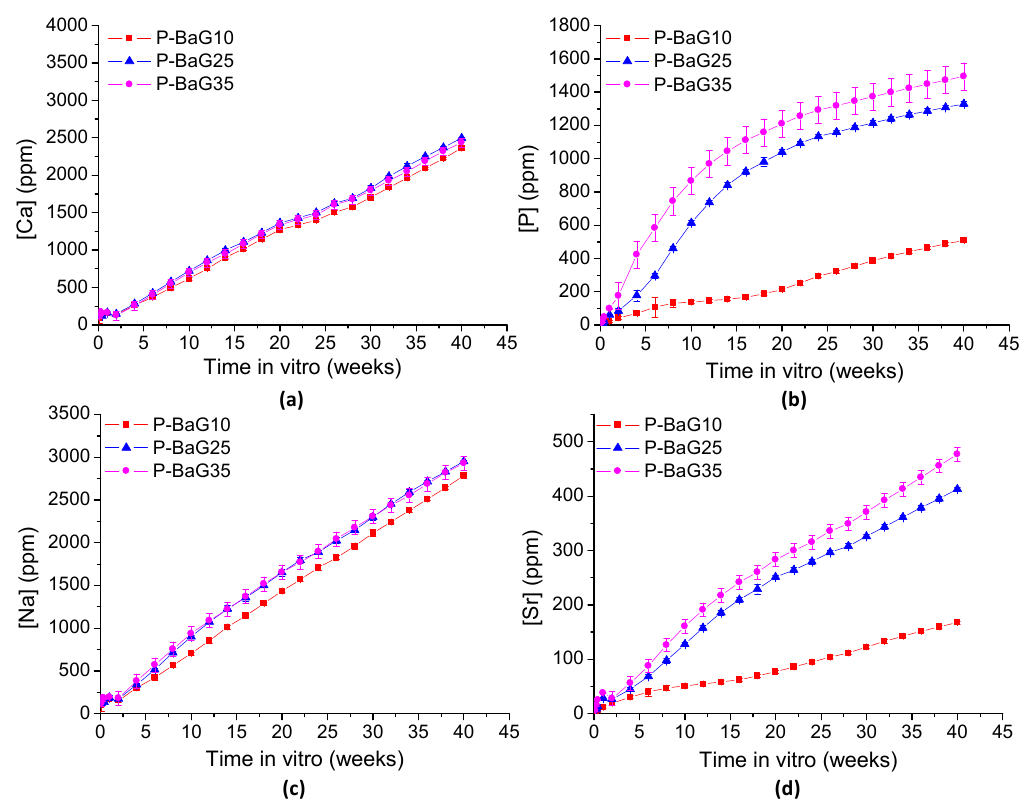
Figure 6. The ( a ) calcium, ( b ) phosphorus, ( c ) sodium, and ( d ) strontium ions released from the P-BaG composites into the Tris solution over 40 weeks.